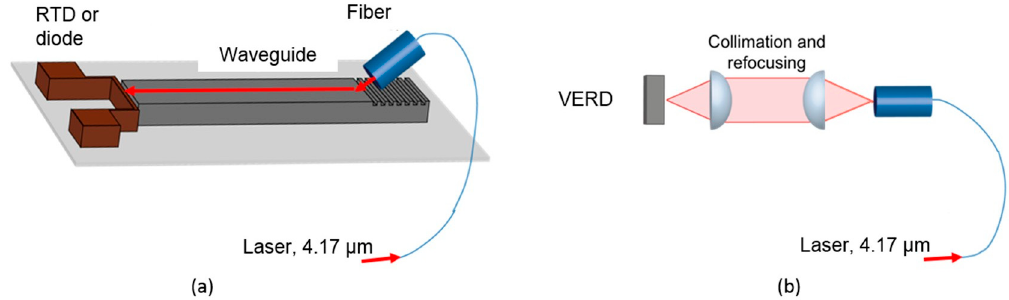
Figure 2. Schematic view of the experimental setup for characterization of ( a ) the integrated RTD and diode structures in front of a waveguide and ( b ) the VERD structure.